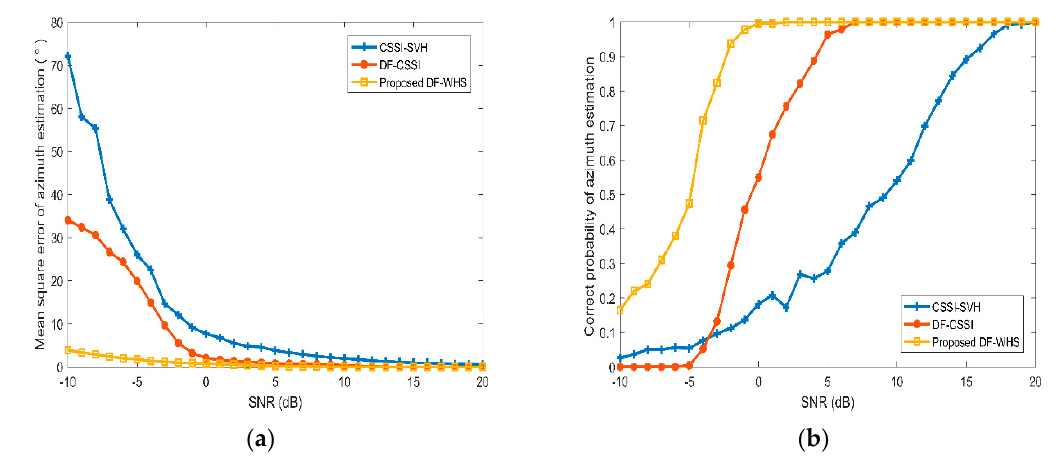
Figure 8. Performance analysis of algorithms with signal-to-noise ratio (SNR) variation . ( a ) Mean square error; ( b ) correct probabilities.